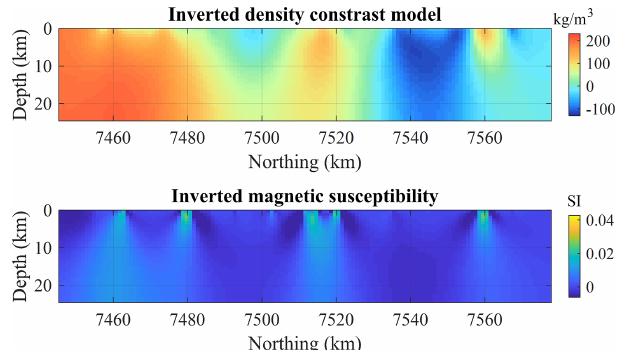
Figure 10. Results from separate inversions using smallness and smoothness constraints. The starting and prior models are equal to zero everywhere, and the smoothness constraint is applied homoge-